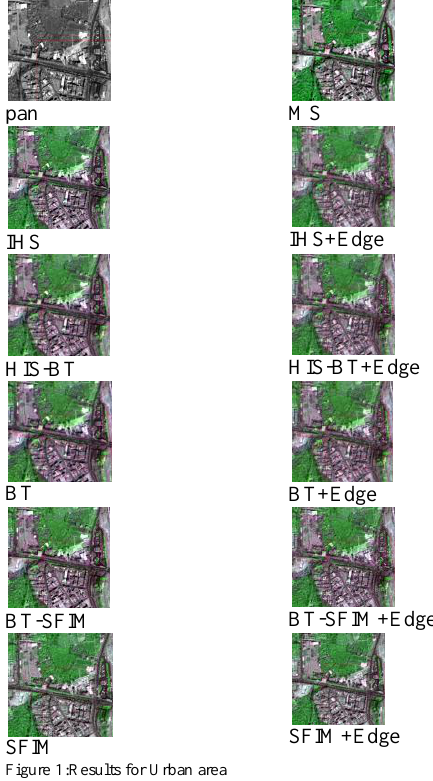
Figure 1:Results for Urban